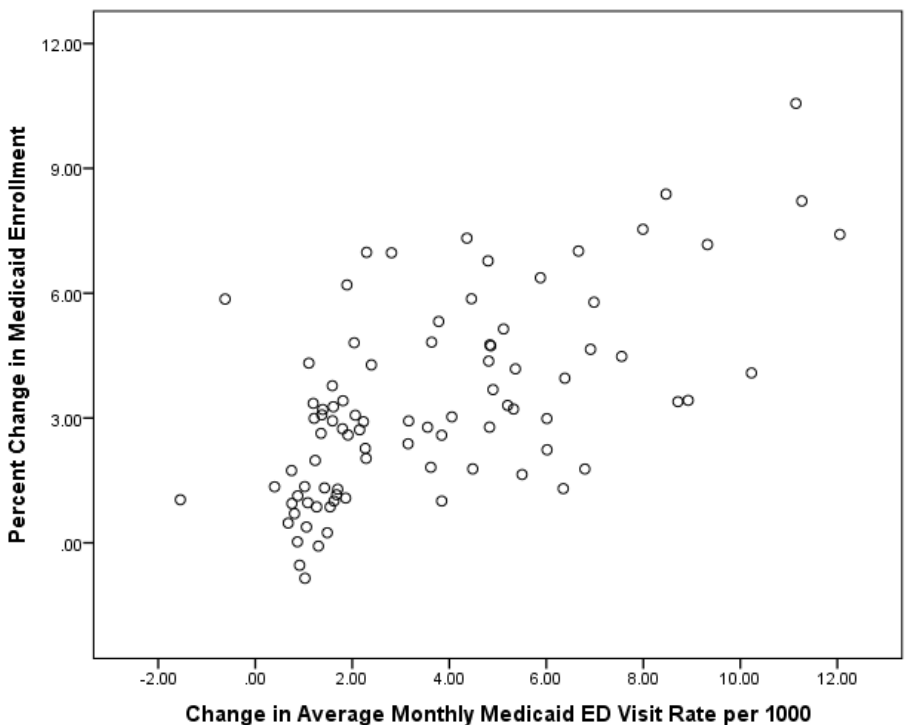
Figure 4. Correlation between change in Medicaid enrollment and change in average monthly Medicaid emergency department (ED) visits before (2013-14) and after (2014-15) Affordable Care Act insurance expansion. r=0.63,